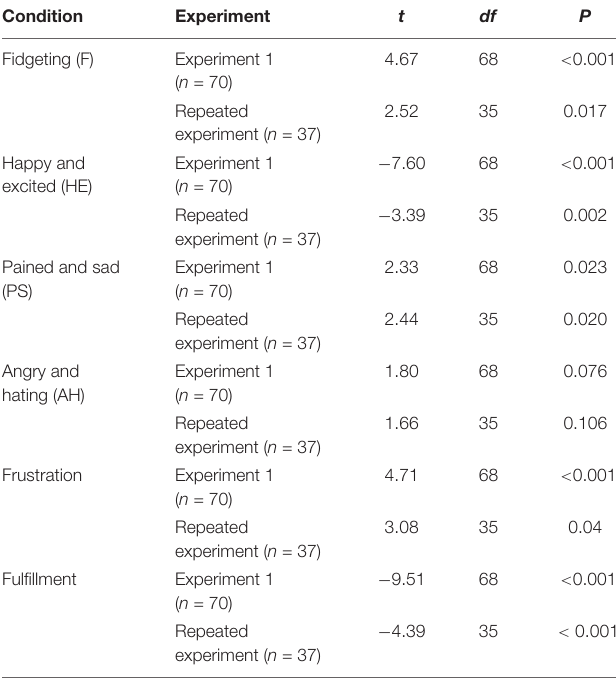
TABLE 6 | Results of T -tests in the repeated experiment and experiment 1.